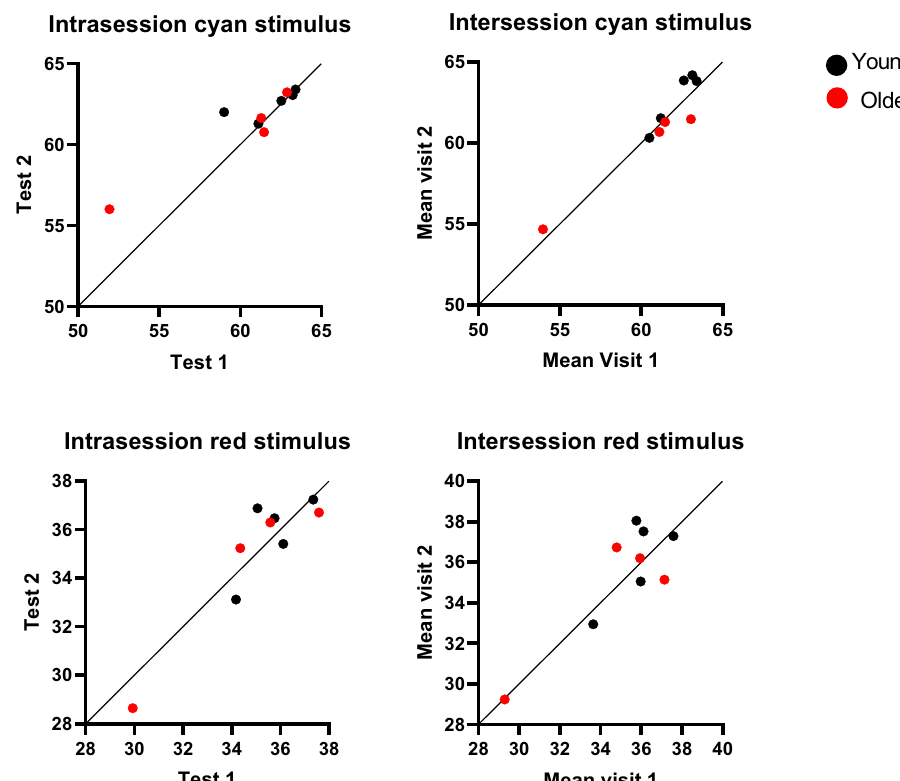
Figure 2. Scatter plots showing mean retinal sensitivity for both cyan and red stimuli of tests within one session and between two visits (young participants N = 5; older participants N = 4). The dots above the line of identity indicate improvement in the second session (test 2 or visit 2) and the dots below the line of identity indicate a decline in the second